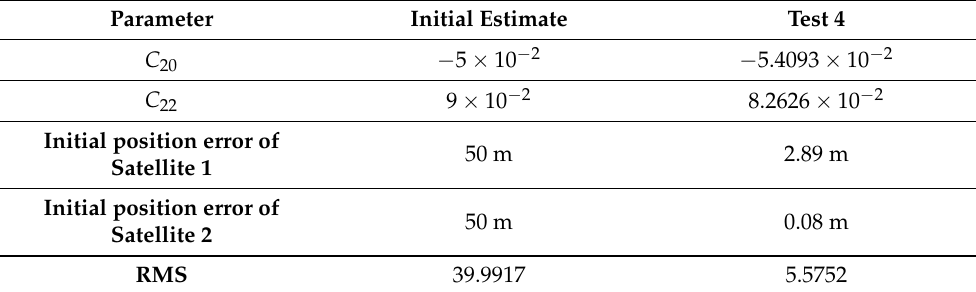
Figure 10. Residual in the range data ( left ), residual in the angle data ( middle ) and norm of the position error of the determined orbit from the true one ( right ) (test 7). Table 7. Recovery result of test